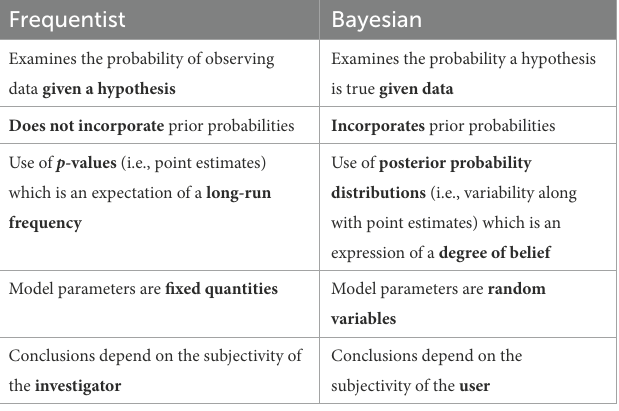
TABLE 1 Comparison of frequentist and Bayesian methods.